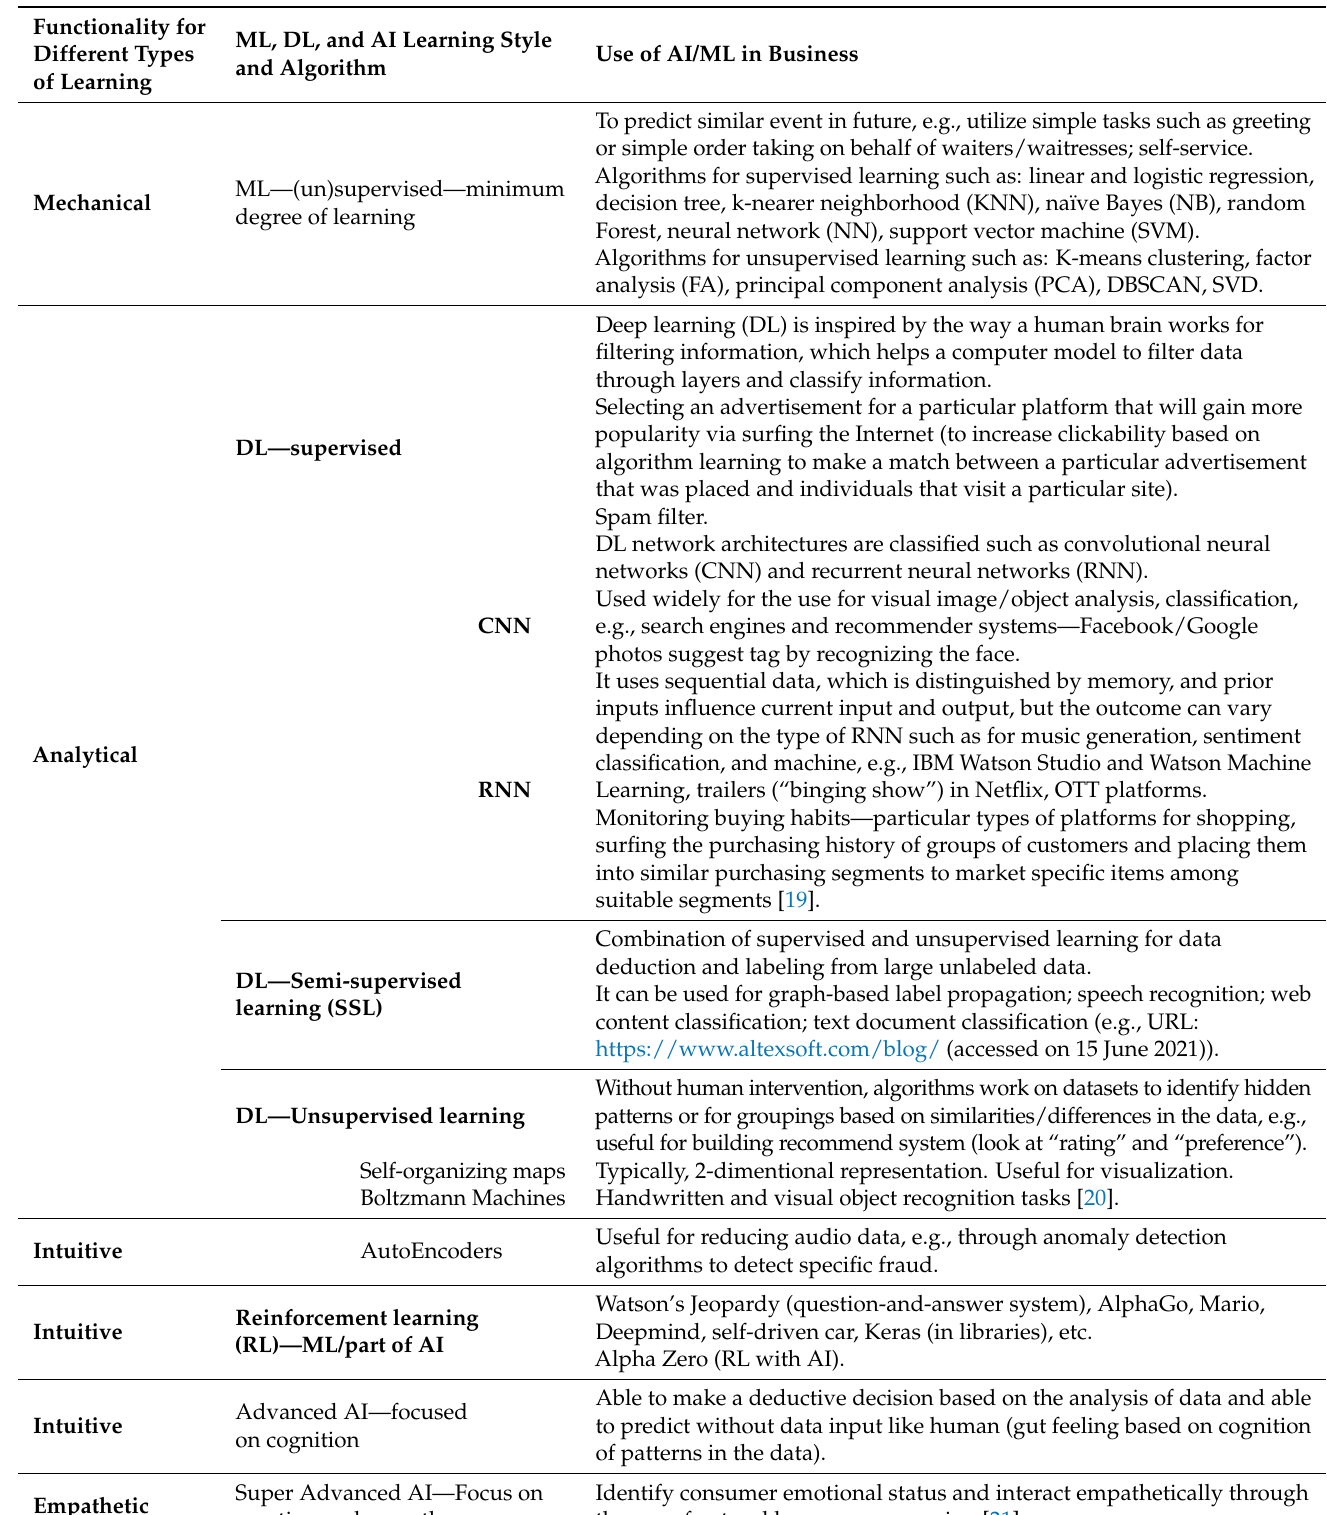
Table 1. The different types of learning associated with